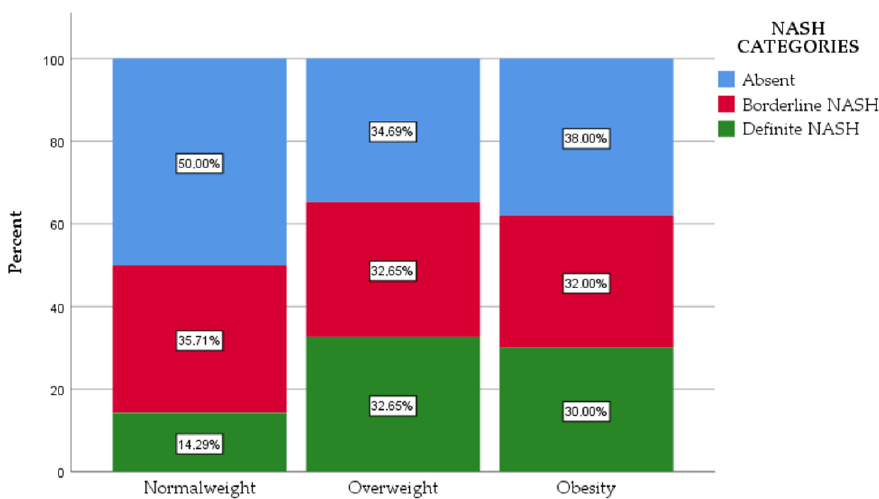
Figure 2. The distribution of the study groups according to NASH category. showing mean values of 8.85 ± 0.75 in the subjects without liver steatosis and 8.93 ± 0.6 shown in Figure 3a.